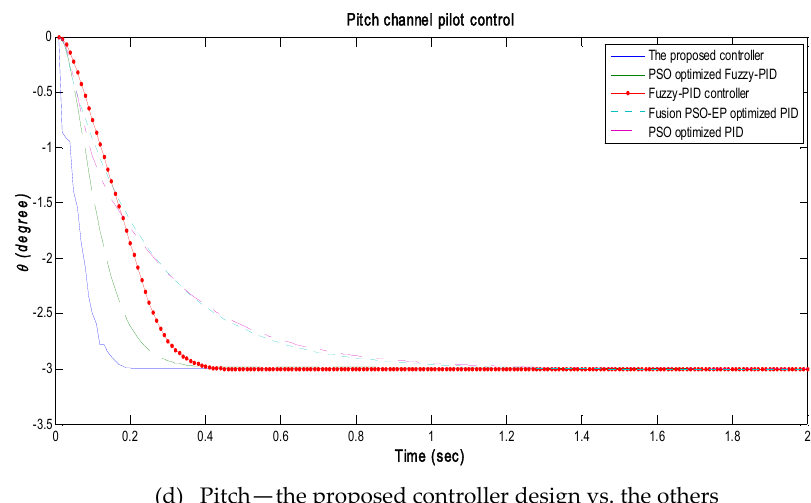
Figure 6. Pitch channel pilot control . ( a : top left) Fitness function of the proposed controller design. ( b : top right) PID parameter in 3-D convergence space. ( c : middle) The minimum of IAE(e) and IAE(de) in 2-D. ( d : bottom) Controllers of the pitch angle response.